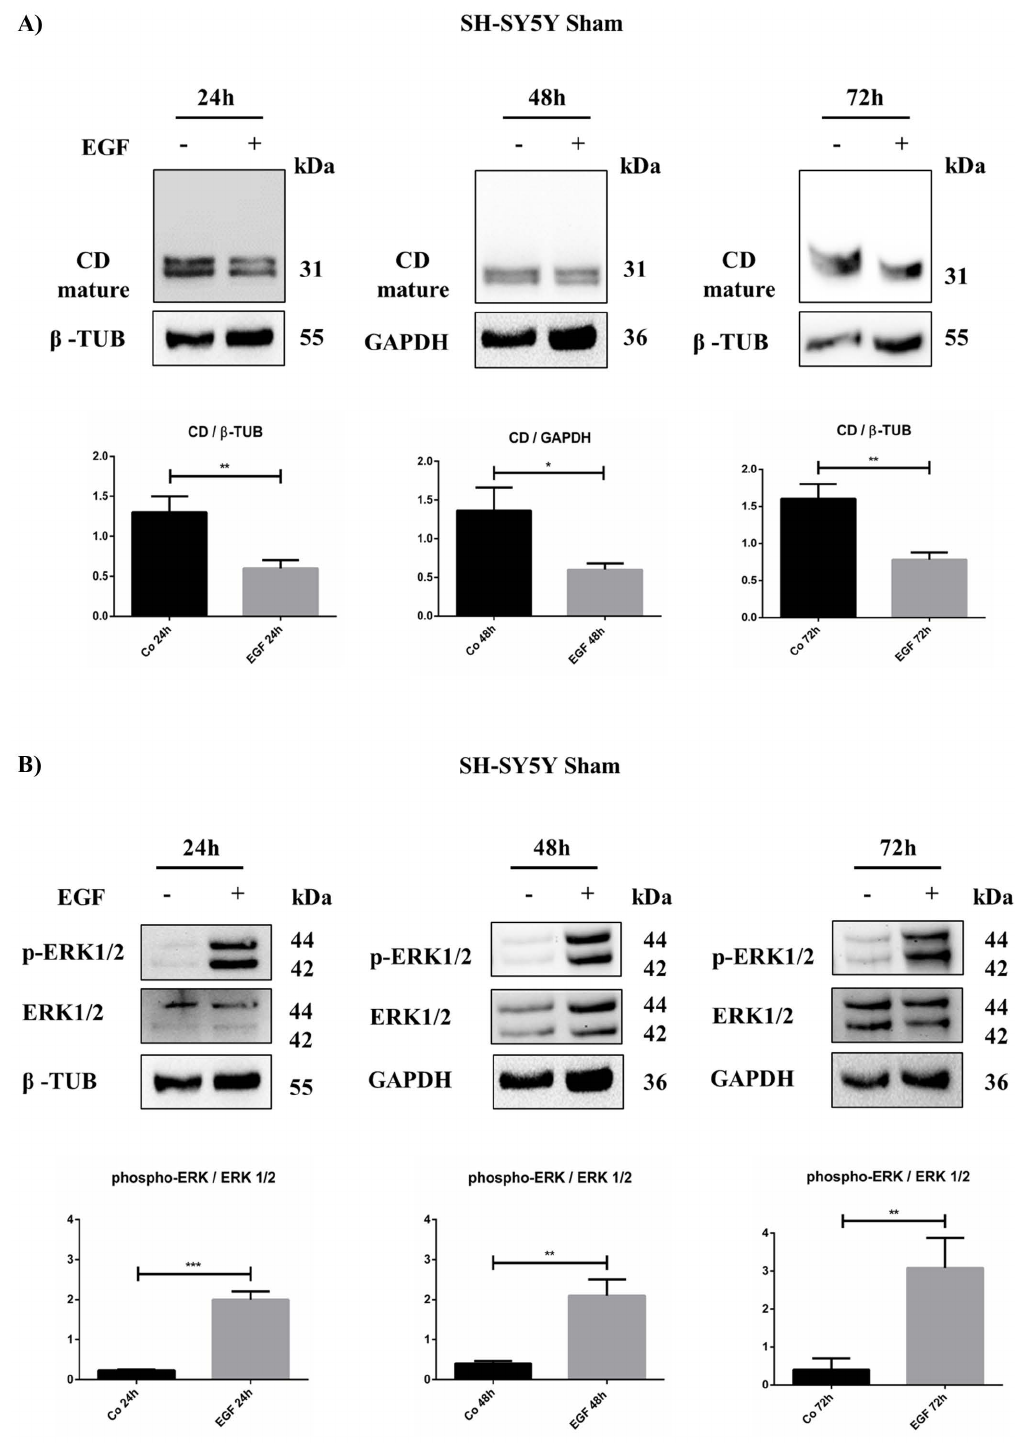
Figure 7. EGF downregulates intracellular cathepsin D in SH-SY5Y Sham. SH-SY5Y cells were treated for 24, 48, and 72 h. ( A ) Time course of cathepsin D expression analyzed through western blotting. ( B ) Western blot of phospho-ERK 1/2 and total protein in Sham cell homogenates at different time points (24, 48, and 72 h) in the presence/absence of EGF. The filters were probed with β -tubulin and GAPDH as loading control. Significance was considered as follows: *** p < 0.001; ** p < 0.01; * p <